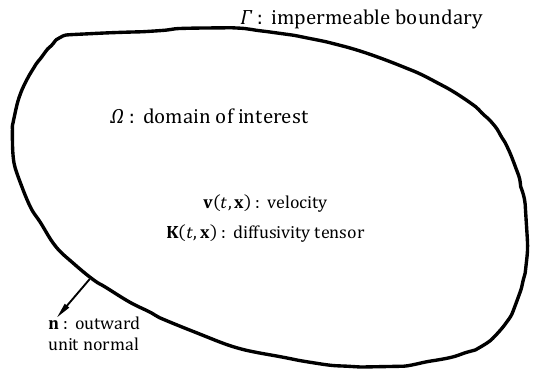
Figure 1. Schematic representation of domain of interest Ω delimited by insulating (or impermeable) boundary Γ , whose outward unit normal is vector n , with | n | = 1. The velocity and the diffusivity tensor are time- and